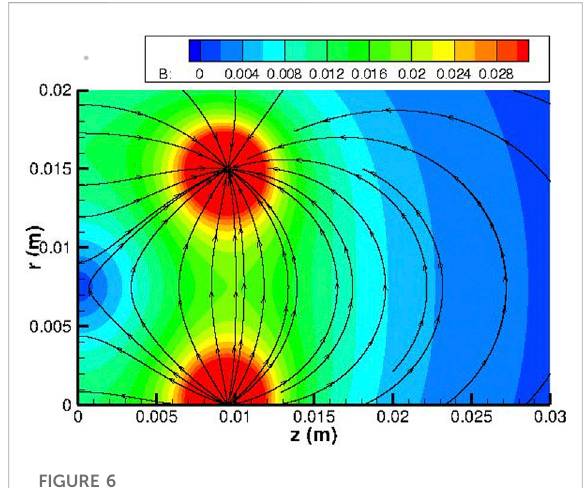
FIGURE 6 Magnetic fi eld topology (streamlines in black and B fi eld magnitude in Tesla) used for all analyzed